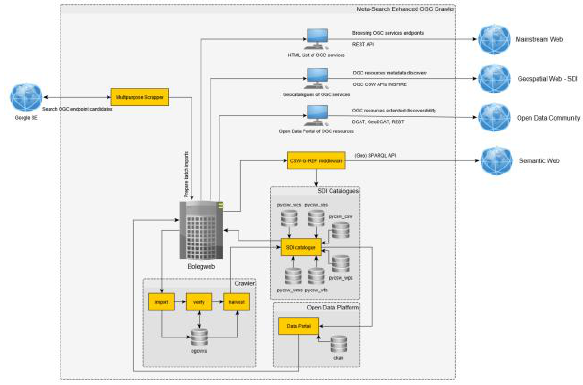
Figure 3 Bolegweb system architecture overview